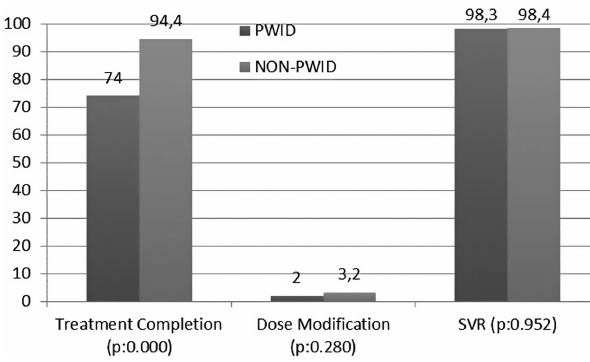
Figure 2. Outcome of antiviral therapy between PWID and non-PWID. SVR, sustained virologic response 12 weeks after treatment completion; PWID, people who inject